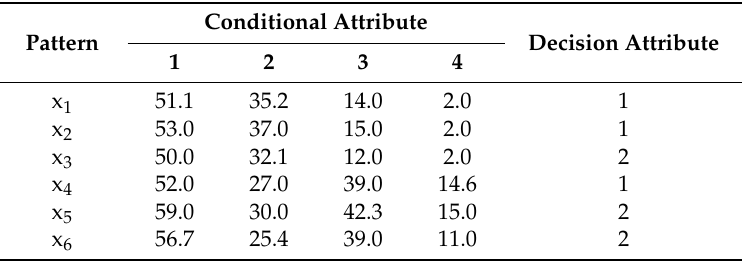
Table 1. An example decision